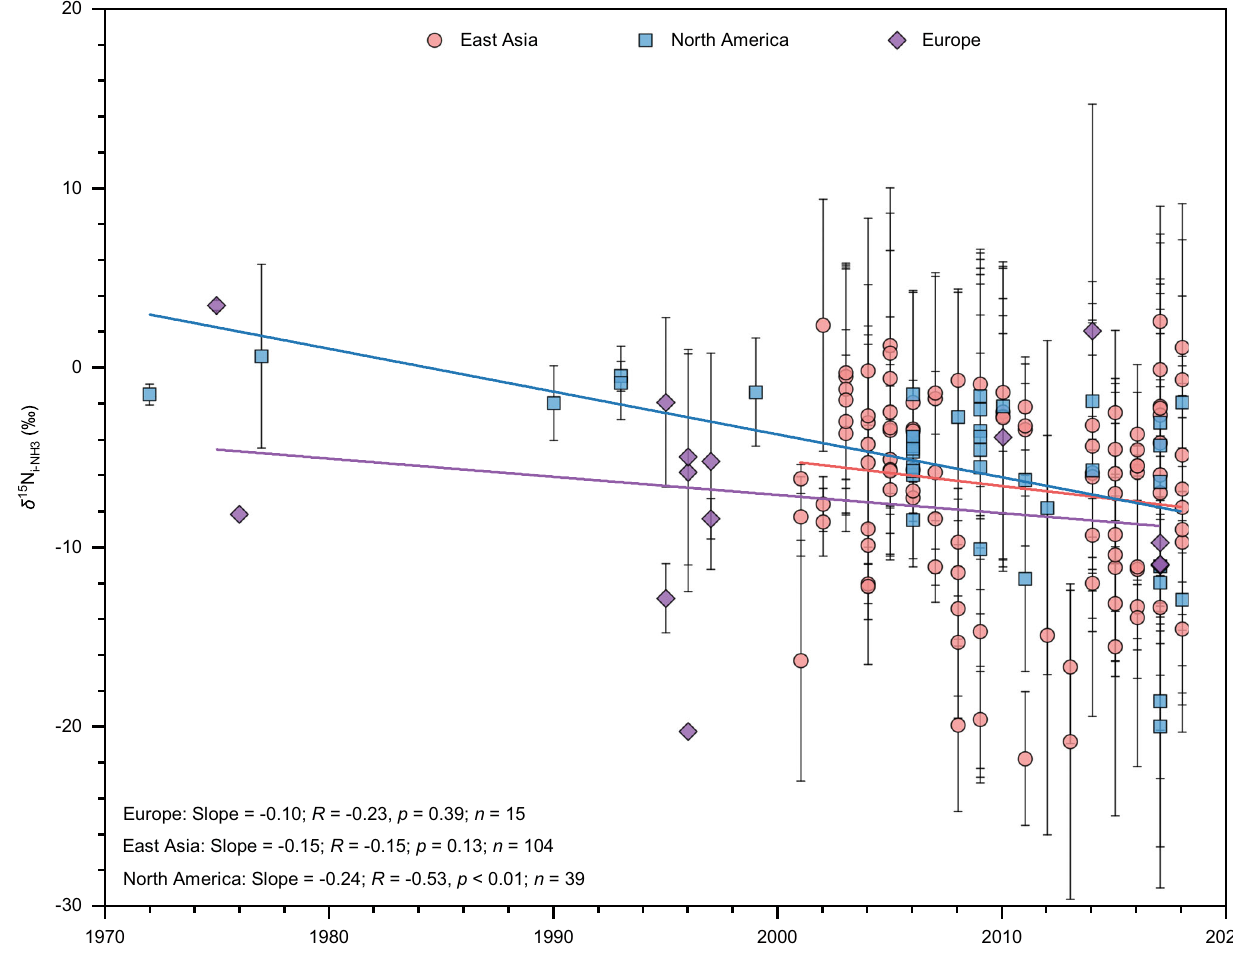
Fig. 4 | Temporal variations of δ 15 N of the initial NH 3 mixture from different sources ( δ 15 N i-NH3 ) in East Asia, North America, and Europe. The mean±SD of replicate measurements at each site in each year is shown. We counted the same